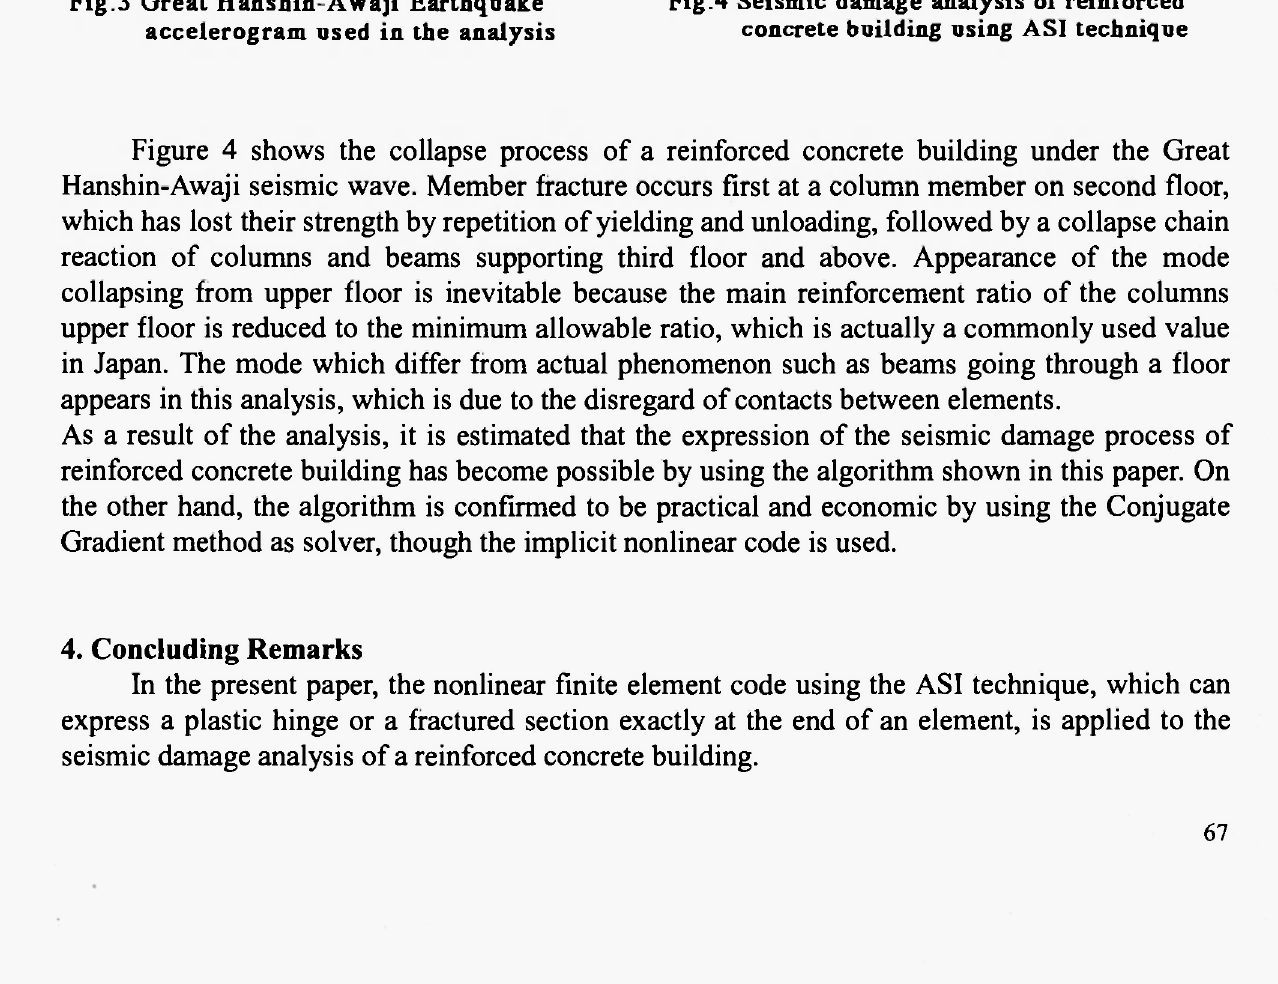
Fig.4 Seismic damage analysis of reinforced concrete building using ASI